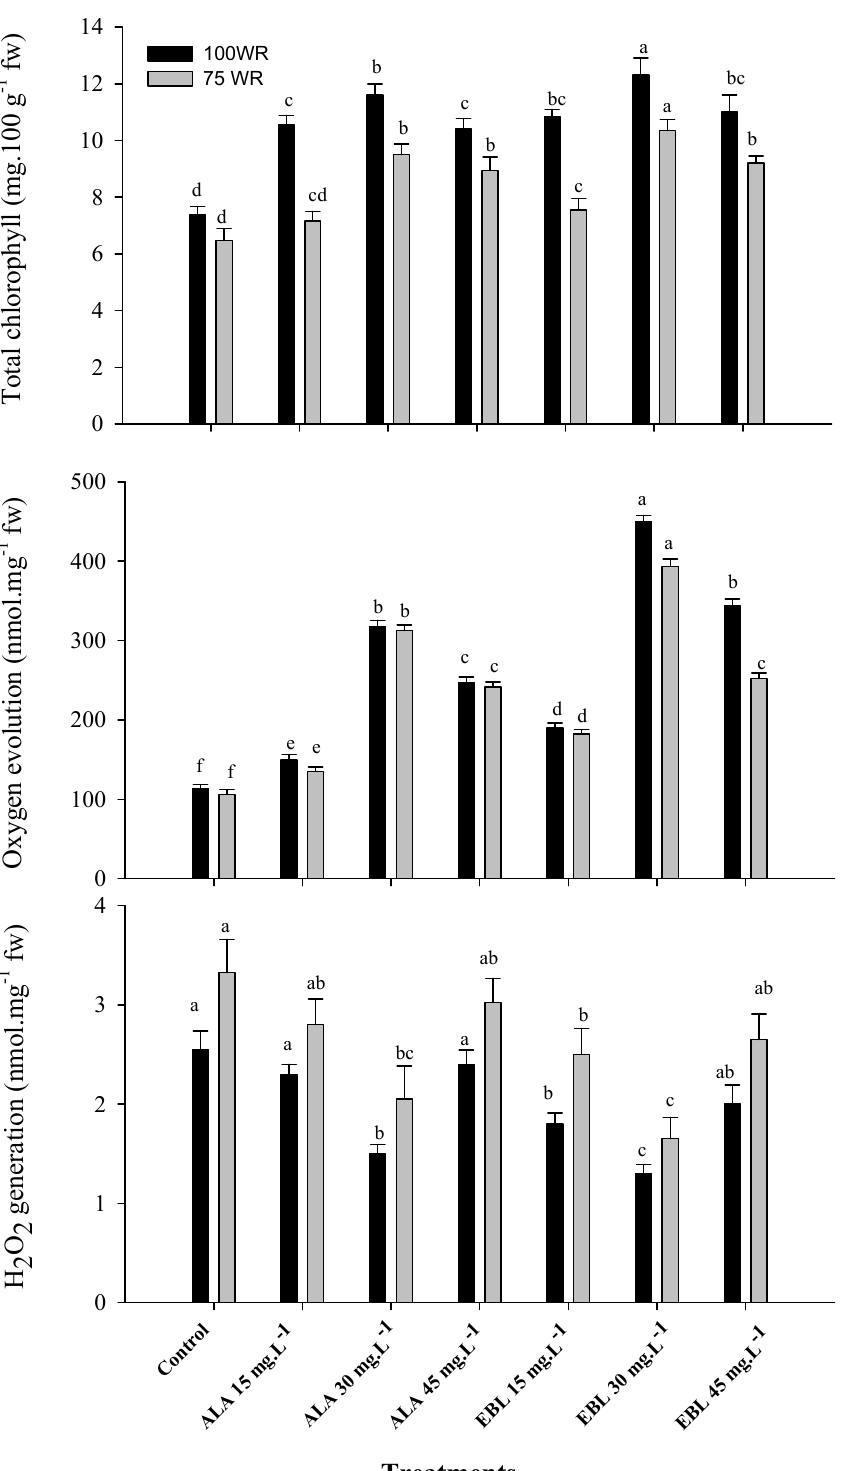
Figure 2. Effect of foliar spray with ALA or EBL on the leaf total chlorophyll content, photosynthetic oxygen evolution, and H 2 O 2 generation of drought-stressed “Williams” banana plants during the 2018/2019 and 2019/2020 seasons ( n = 5). The results are the averages of both seasons, and DMRT was used for mean comparisons of treatments under each WR level ( p ≤ 0.05).